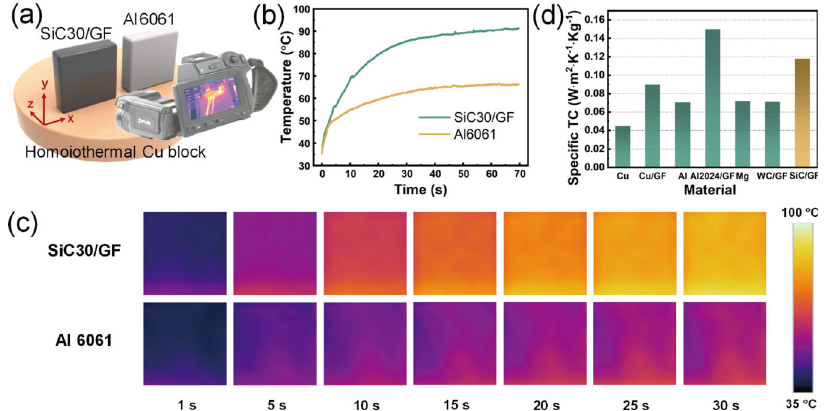
Fig. 10 (a) Schematic diagram of the heat dissipation experiments. (b) Side surface temperature–time curves of the samples. (c) Changes of infrared thermal images over time. (d) Specific TC of SiC30/GF composite compared with several key TMMs